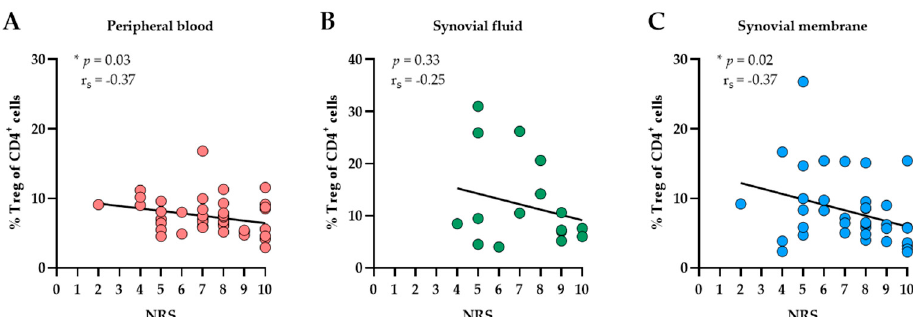
Figure 5. Correlation analyses between tissue-specific infiltration of Tregs and pain of knee OA patients. Spearman’s rank correlation coefficient (r s ) revealed that Treg proportions (% Treg) in ( A ) peripheral blood and ( C ) synovial membrane (SM) significantly correlated with knee pain intensity measured on a numerical rating scale (NRS). Higher pain levels were associated with decreasing Treg proportions in PB and SM. ( B ) In synovial fluid, no associations between Treg proportions and pain scores were observed. p -Values < 0.05 were considered statistically significant and are indicated with asterisks: * p < 0.05.